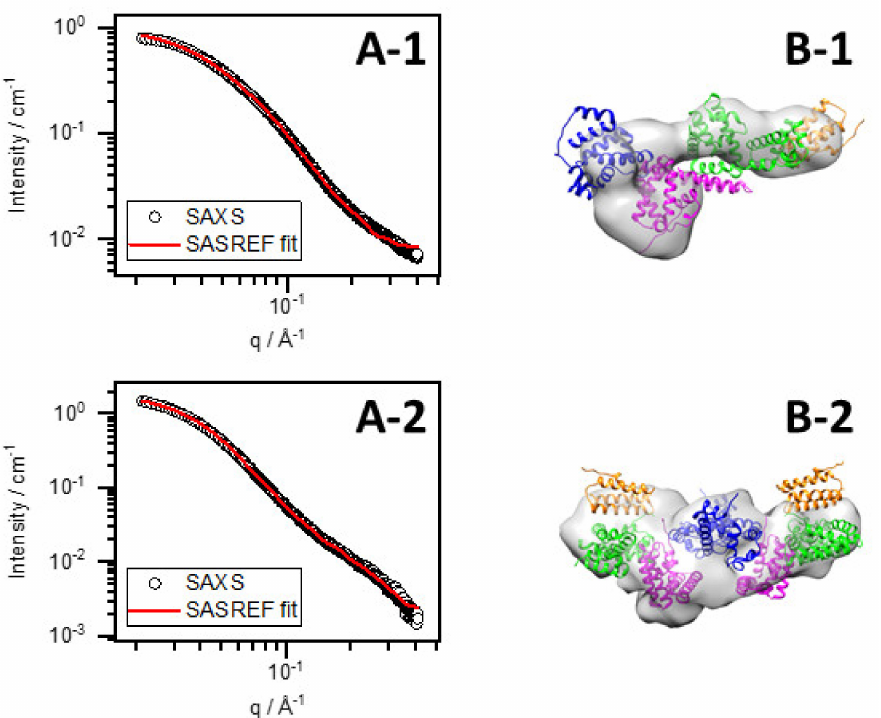
Figure 6. SAXS curve of BSA–Au conjugates at pD ~12 and SASREF fit ( A-1 ), SAXS curve of BSA– Au conjugates at pD ~7 and SASREF fit ( A-2 ), obtained SASREF (cartoon) and DAMMIF (surface) structures ( B-1 , B-2 ).